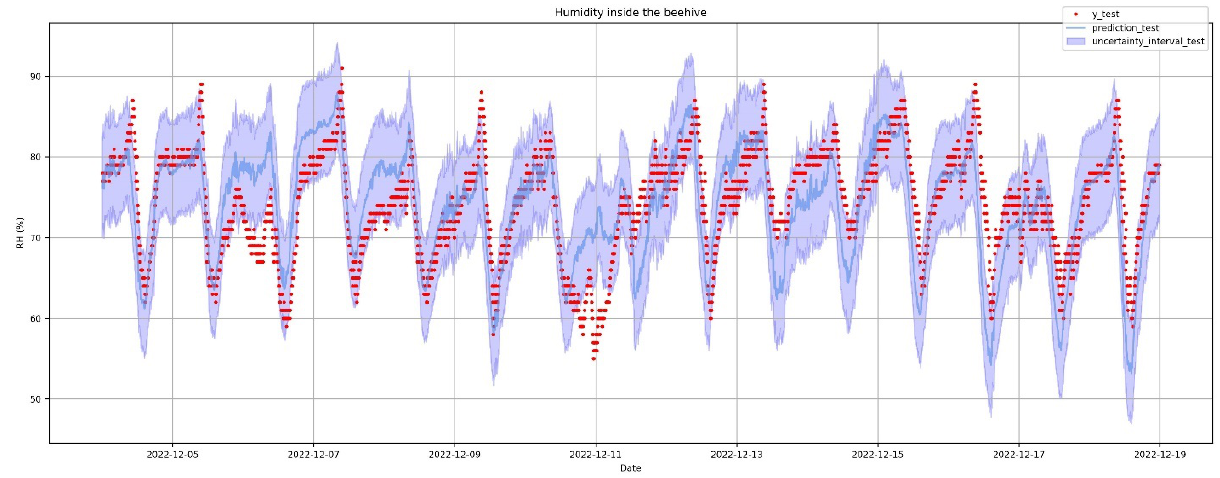
Figure 16. Prophet: prediction of humidity inside the hive. Zooming in the test period.